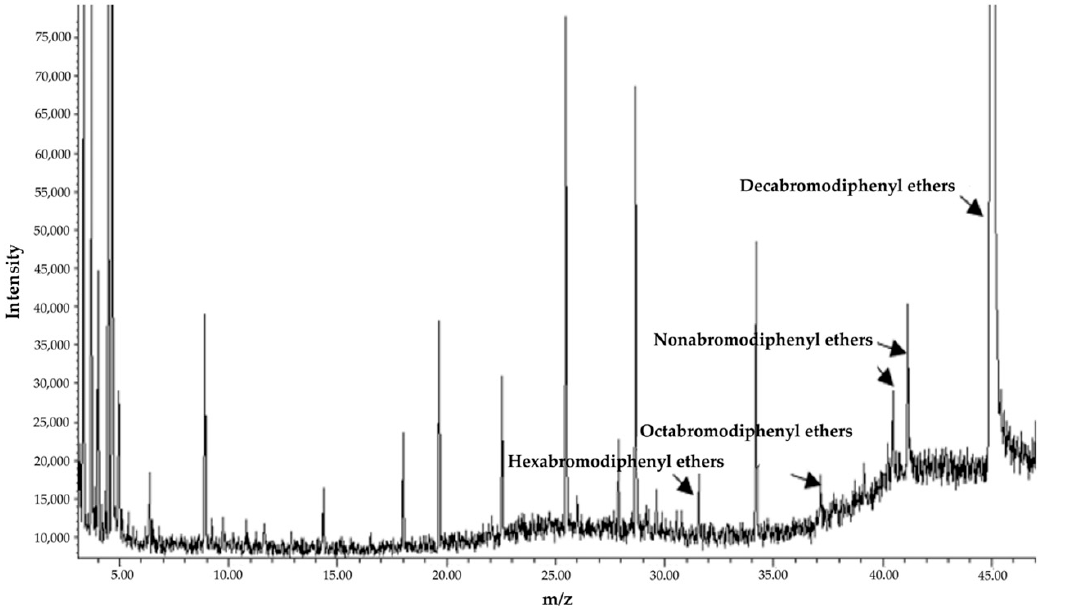
Figure 6. Total ion chromatogram of BDE-209 degrading culture (TAW-CT127) extract.